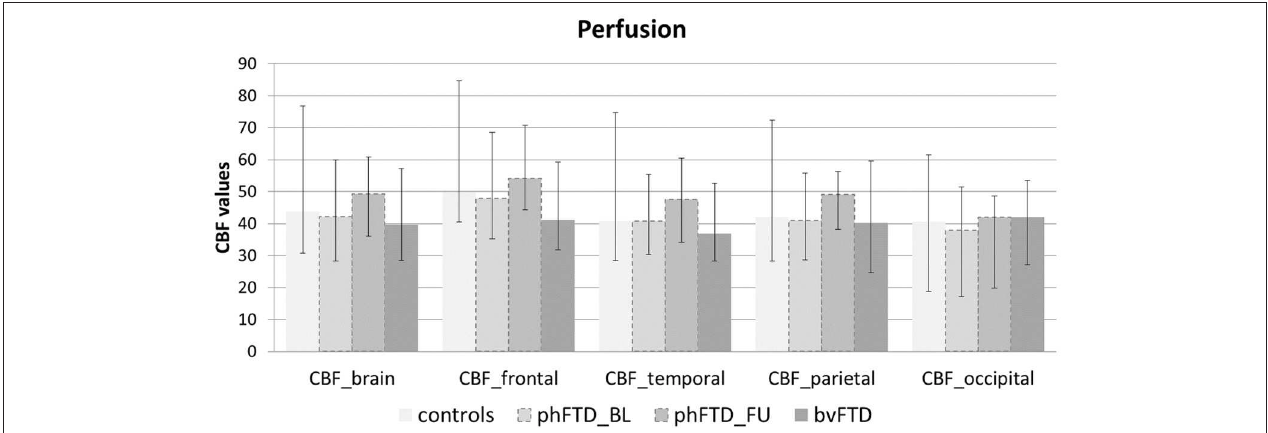
FIGURE 4 | Whole-brain perfusion and lobar perfusion shown for each group (controls, baseline phFTD, follow-up phFTD, bvFTD). The range of perfusion is indicated by a minimum-maximum bar. CBF, cerebral blood flow; bvFTD, behavioral variant frontotemporal dementia; phFTD, phenocopy frontotemporal dementia; BL, baseline; FU,